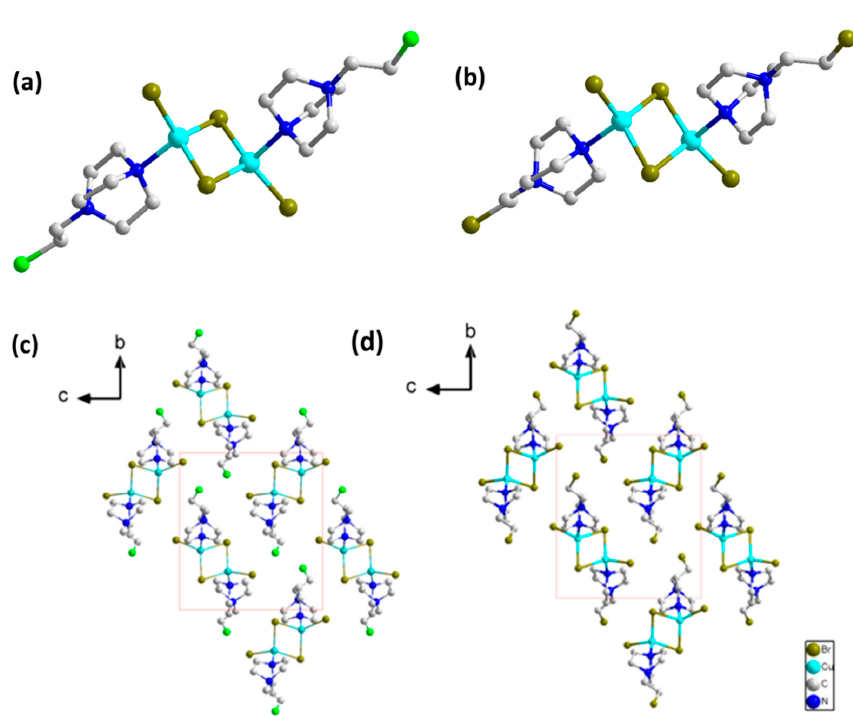
Figure 2. Synthetic routes of L 1 and L 2 .